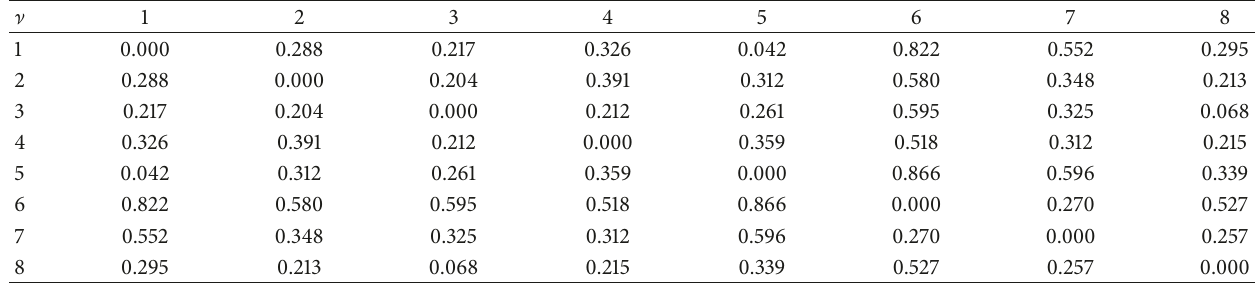
Table 2: Nonmembership parts of the intuitionistic fuzzy pairs, giving the intercriteria correlations between measurements of crude oil